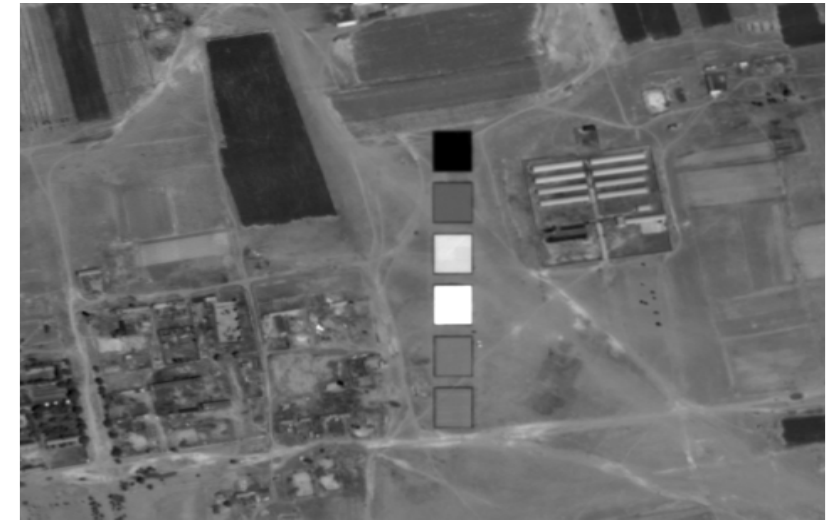
Figure 4. The arrangement of the calibration tarps at the RadCalNet Baotou site.